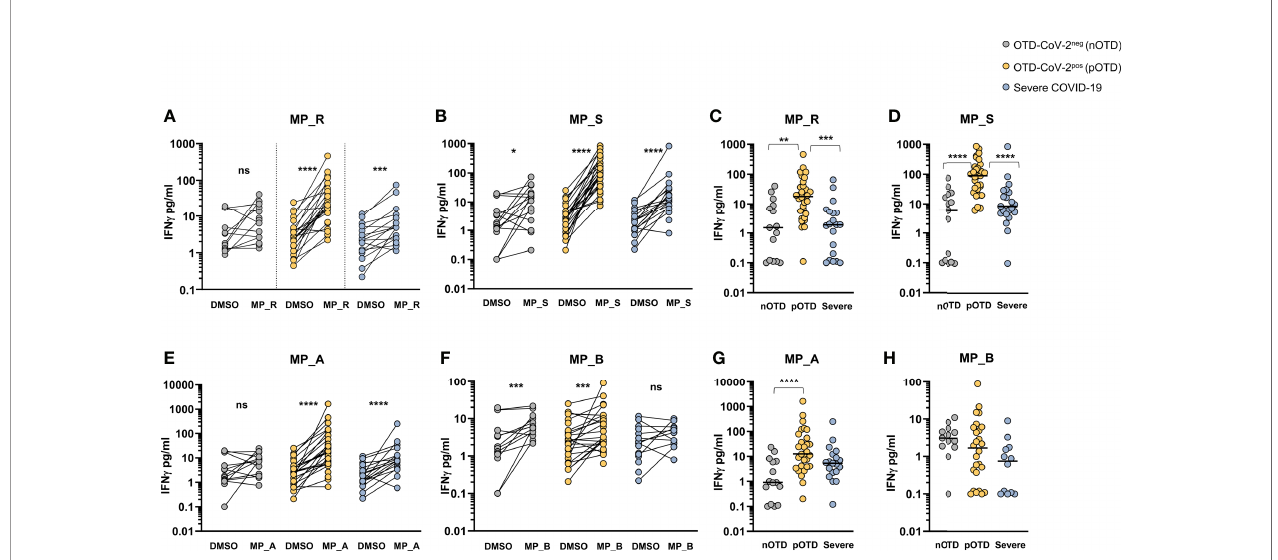
FIGURE 3 | SARS-CoV-2-speci fi c T cells from individuals with OTD produce more IFN g than patients with severe COVID-19. (A, B) Amount of IFN g (pg/mL) in the supernatants of AIM assay after PBMC stimulation with CD4-speci fi c MP_R and MP_S peptide pools. Data are shown in comparison with the vehicle control (DMSO), per donor. (C, D) DMSO-subtracted IFN g concentrations (pg/mL) after MP_R and MP_S stimulation in SARS-CoV-2 negative subjects with olfactory-taste disorder (nOTD), SARS-CoV-2 positive subjects with olfactory-taste disorder (pOTD) and severe COVID-19 patients. (E, F) IFN g levels in the AIM supernatants after stimulation with CD8-speci fi c MP_A or MP_B peptide pools. Data are shown in comparison with the vehicle control (DMSO), per donor. (G, H) Comparison of the background (DMSO)-subtracted IFN g levels across the three cohorts of patients after MP_A and MP_ B stimulation. The non-parametric Wilcoxon matched-pairs signed-rank test was used to compare data within the same group. Statistical comparison between three groups of subjects was assessed by the non-parametric Kruskal-Wallis test followed by Dunn ’ s multiple comparisons. *p < 0.05; **p < 0.01; ***p < 0.001; ****p <